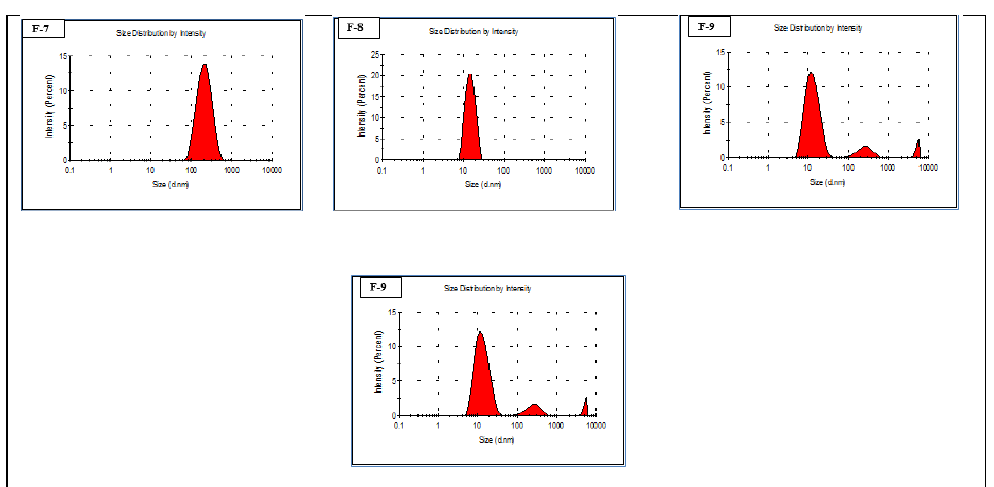
Figure 6. Particle size distribution of LCDP NEs formulas (7, 8 and 9) respectively . Polydispersity index measurement